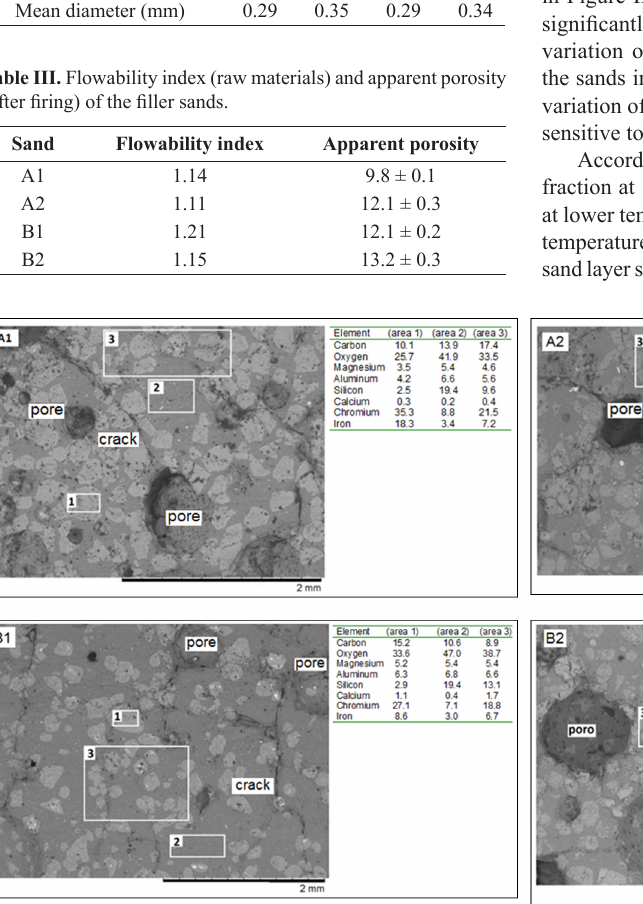
Figure II. Microstructures of the sintered sands (A1, A2, B1 and B2) at 1600ºC. EDS analysis in the